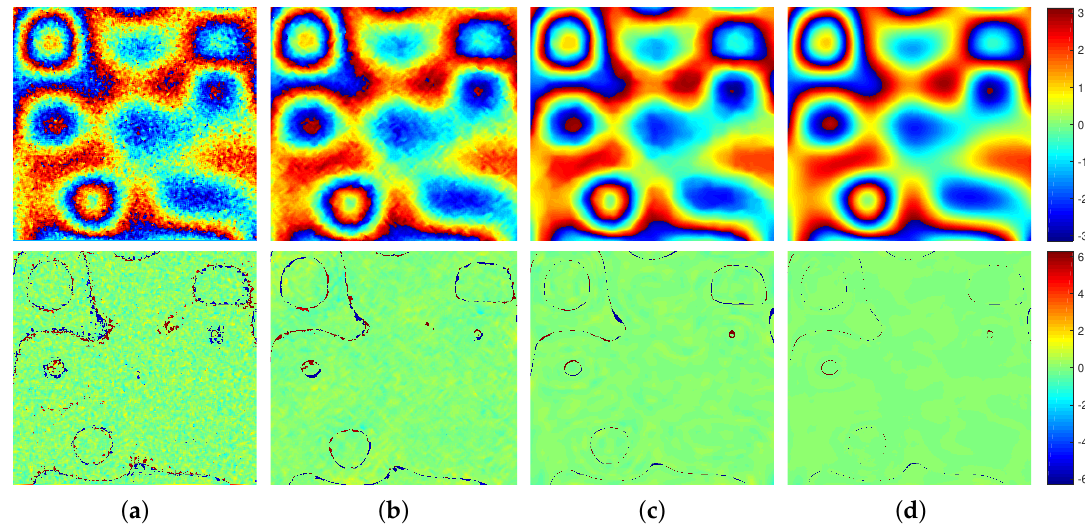
Figure 12. Filtered results (Top) and phase difference (Bottom) of four methods on simulated data. ( a ) Lee filter. ( b ) Goldstein filter. ( c ) InSAR-BM3D filter. ( d ) Proposed method.